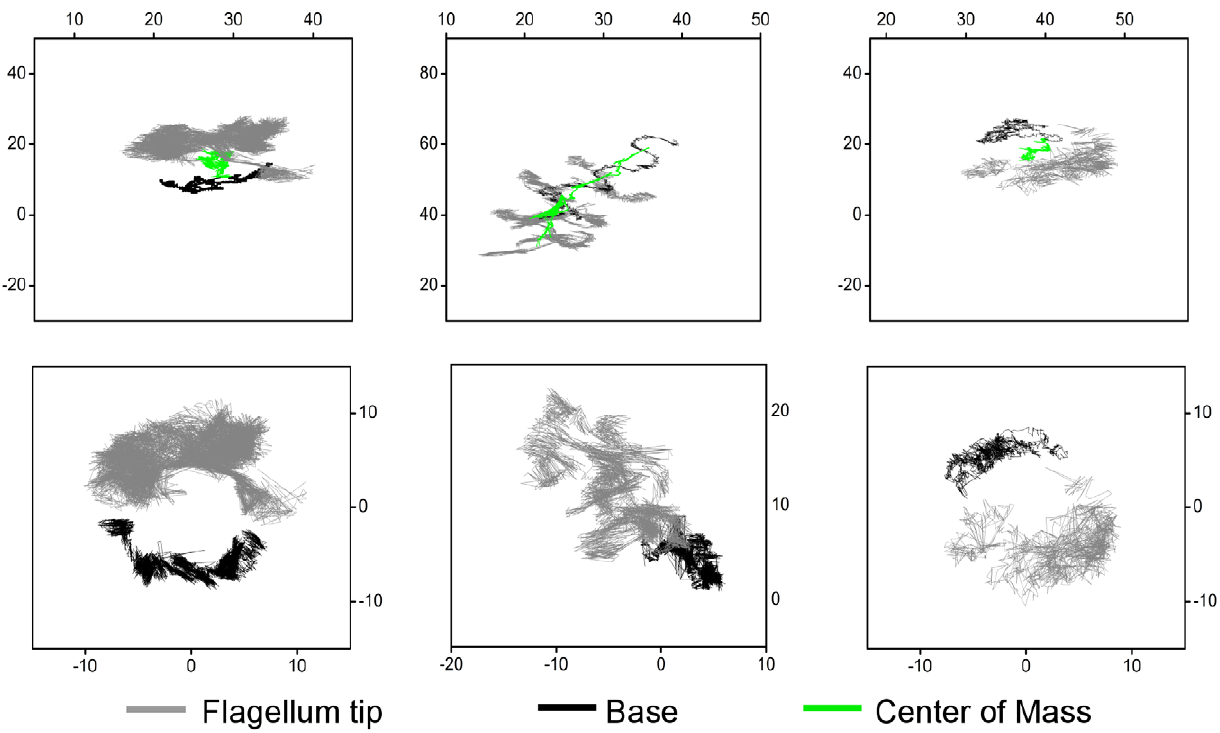
Figure 5. Cell-end trajectories. Trajectories of tip (grey) and base (black) as well as center of mass (green) shown for 9 s (units are m m ). Top three panels show the movement of the flagellum tip and base as well as the center of mass. Lower panels show the corresponding cell-end trajectories with a center of mass correction allowing us to isolate center of mass movements from cell-end movements. Left and right panels: persistent walkers, middle panel: tumbling walker - persistence is not apparent at this time scale.